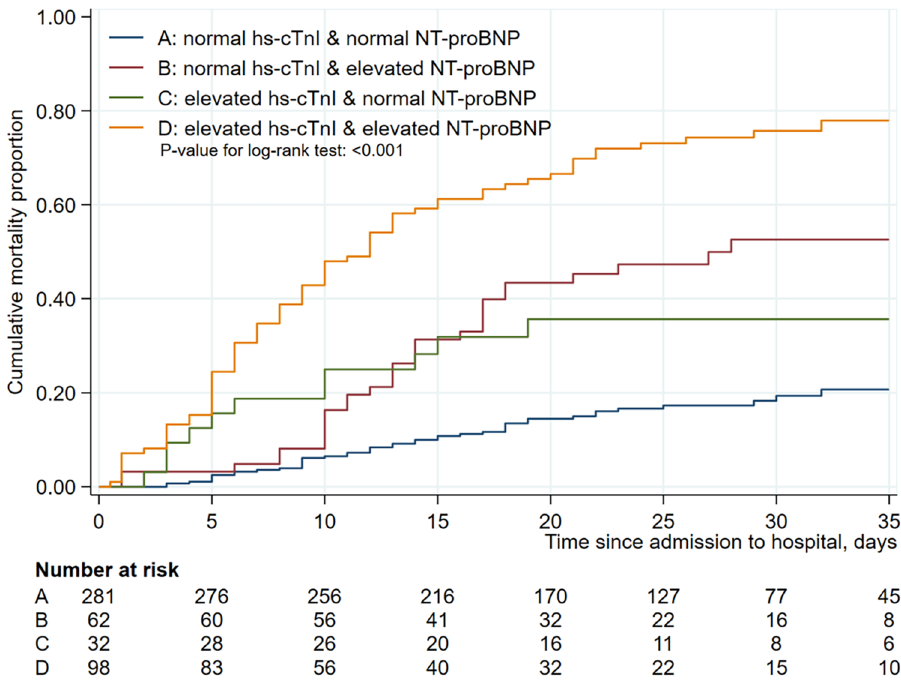
Figure 2. Cumulative mortality rate among hospitalized severe patients with COVID-19 according to the combination of hs-cTnI and NT-proBNP*. Kaplan–Meier estimates representing the probability of death in the hospital according to combination of hs-cTnI and NT-proBNP in severe patients. * High hs-cTnI (≥ 34.2 in male, ≥ 15.6 pg/mL in female) and high NT-proBNP (≥ 486